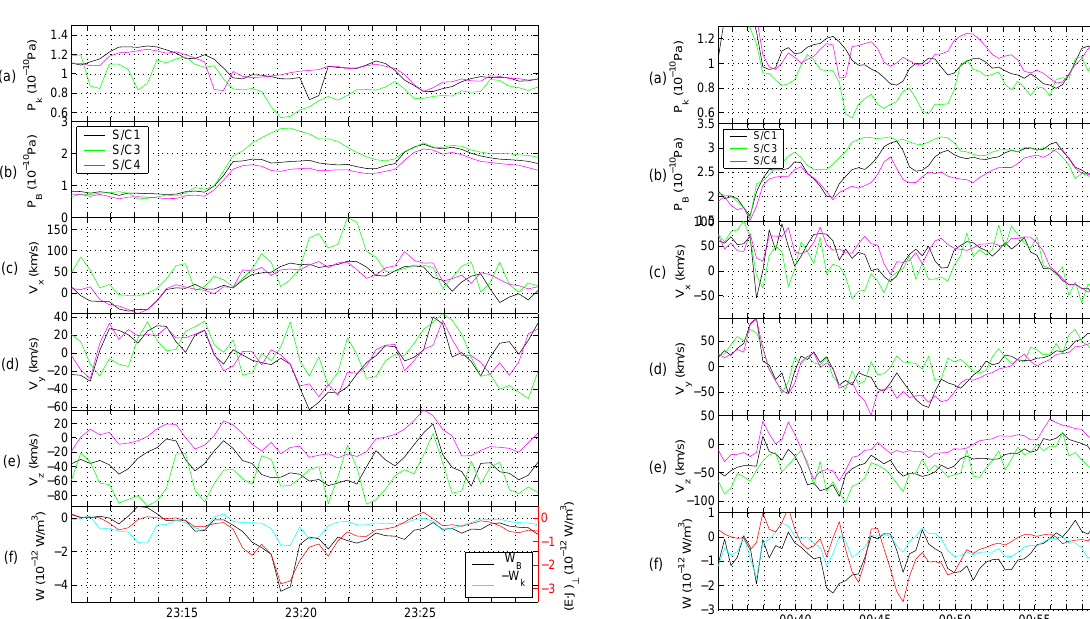
partial derivative ∂ t B 2 /( 2 µ 0 ) can be obtained by estimat- ing the slope of the time series in Fig. 6b. Between 22:14 and 22:17 there is a decrease in the magnetic pressure (en- ergy density) of about 0.2 nPa first seen on S/C 1 and 4, and thereafter on S/C 3. Therefore, ∂ t B 2 /( 2 µ 0 ) ≈− 10 − 12 W / m 2 , which is of the same sign and order as E · J during the time interval. Therefore ∇· S must be positive for Eq. (1) to be satisfied and this is in accordance with a Poynting flux out from CGR1 and is also consistent with CGR1 being inter- preted as a generator. Hence, we can conclude that electro- magnetic energy is generated from the mechanical energy in the plasma pressure, and that some of the electromagnetic energy is transported away from CGR1 as a Poynting flux. From the various curves in Fig. 6 we can construct a pos- sible scenario for the evolution of CGR1. This is illustrated by the diagram in Fig. 9, where we show a projection on the GSE (x, z) plane. Early in the event, at 22:14 UT, the ion pressure is starting to increase, first at S/C 4 and somewhat later at S/C 1, but not yet at S/C 3. The plasma flows at S/C 1 and S/C 4 are mainly earthward ( V x ∼ 200 km / s), with a small southward component ( V z ∼− 50 km / s). A similar southward flow is seen on S/C 3, but V x is insignificant. The magnetic field is slightly reduced at S/C 1 and S/C 4, but at S/C 3 the magnetic field is still unperturbed. This situation is sketched in the top panel of Fig. 9, where the shading indicates the ion pressure and the black arrows represent the observed plasma flows. The white arrow indicates a suggested plasma inflow and the boundary between the plasma sheet and the lobe is indicated with the thick black